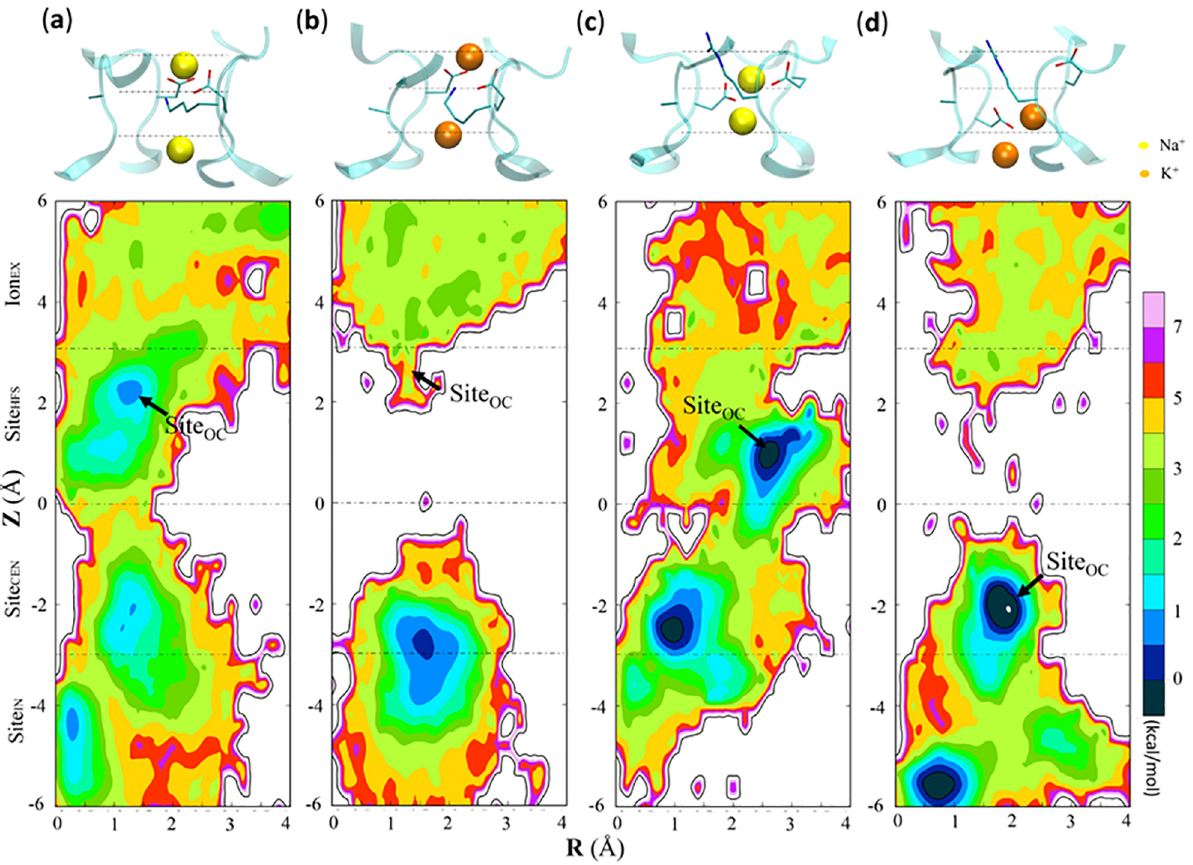
Fig 3. Ion binding patterns in the SF of the DEKA (a, b) and DERA (c, d) mutants of Na v Rh for Na + (a, c) and K + (b, d) ions in the a- system (IDs 13 – 16 in Table B in S1 File). For each map, the upper panel shows a representative structure obtained from the equilibrium simulation. The side chains of residues 180 are shown in the licorice representation for clarity. The SF is shown in the cartoon representation and colored in cyan. Na + and K + ions are represented as yellow and orange spheres respectively. The lower panel exhibits the 2D free energy profile (in the unit of kcal/mol) estimated from the probability density map of cations in SF that is counted from the corresponding 200 ns equilibrium simulation. The vertical axis is the relative distance of the cation to the geometric center of the SF along the z-axis, with labels denoting the binding sites (Ion EX , Site HFS , Site CEN and Site IN ) proposed from the static crystal structure of Na v Ab. Positions of Site OC are labeled by black arrows. The horizontal axis is the distance between cation and the geometric center of the SF projected in the xy-plane.